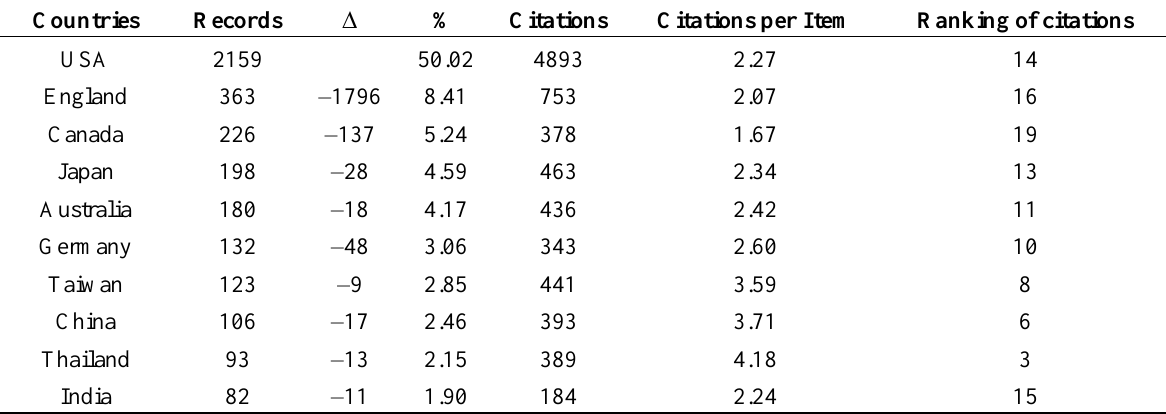
Table 8. Top 20 Countries in order of number of scholarly communications